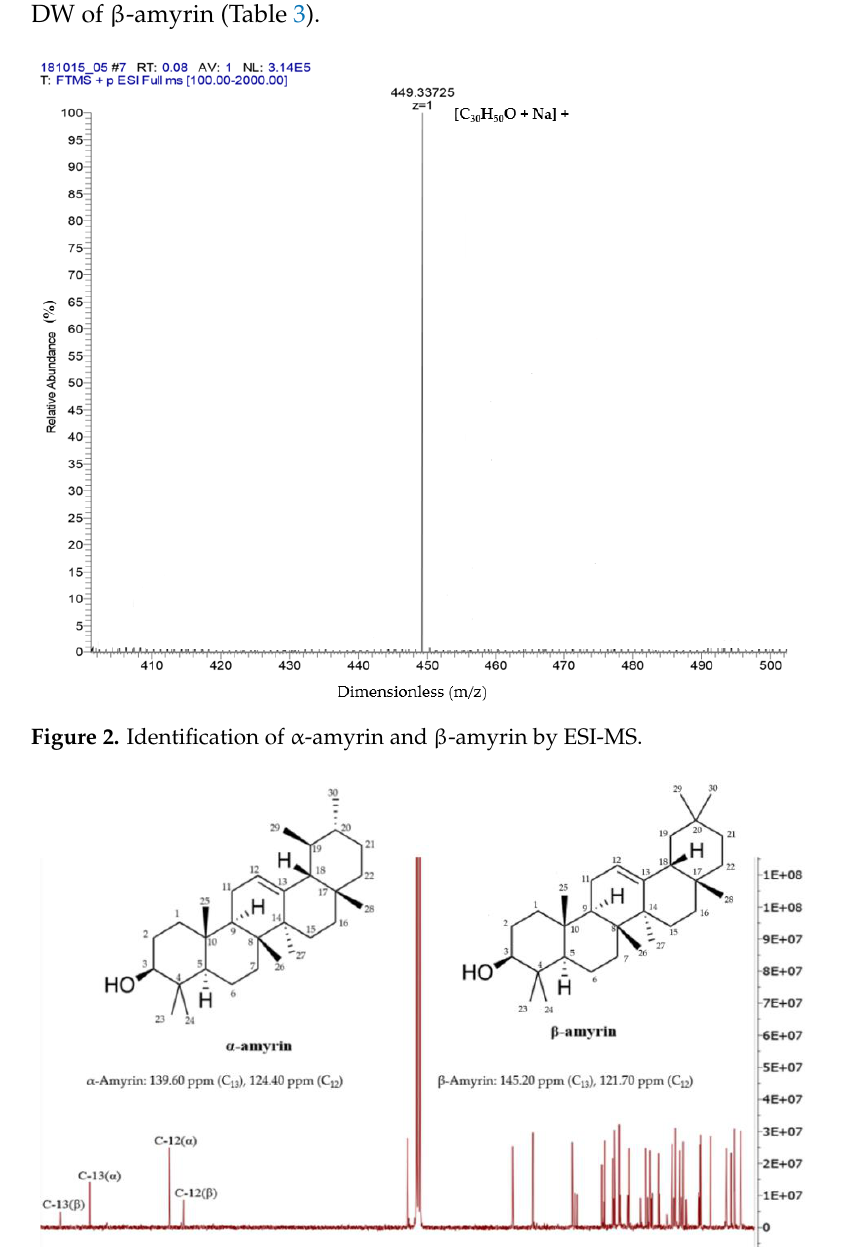
Figure 3. 13 C-NMR spectrum of the mixture of α -amyrin and β -amyrin measured in CDCl 3 Figure 3. 13 C- NMR spectrum of the mixture of α - amyrin and β -amyrin measured in CDCl 3 (125 (125 MHz). Table 2. 13 C-NMR data for α -amyrin and β -amyrin in CDCl 3.